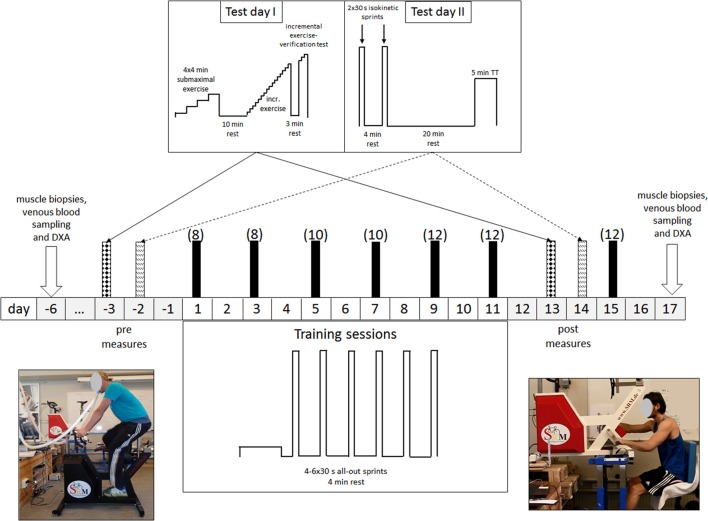
Schematic illustration of our experimental protocol. All testing and training was performed employing both leg-pedaling (left) and arm-cranking (right). The values in brackets indicate the number of 30-s sprints per training session.